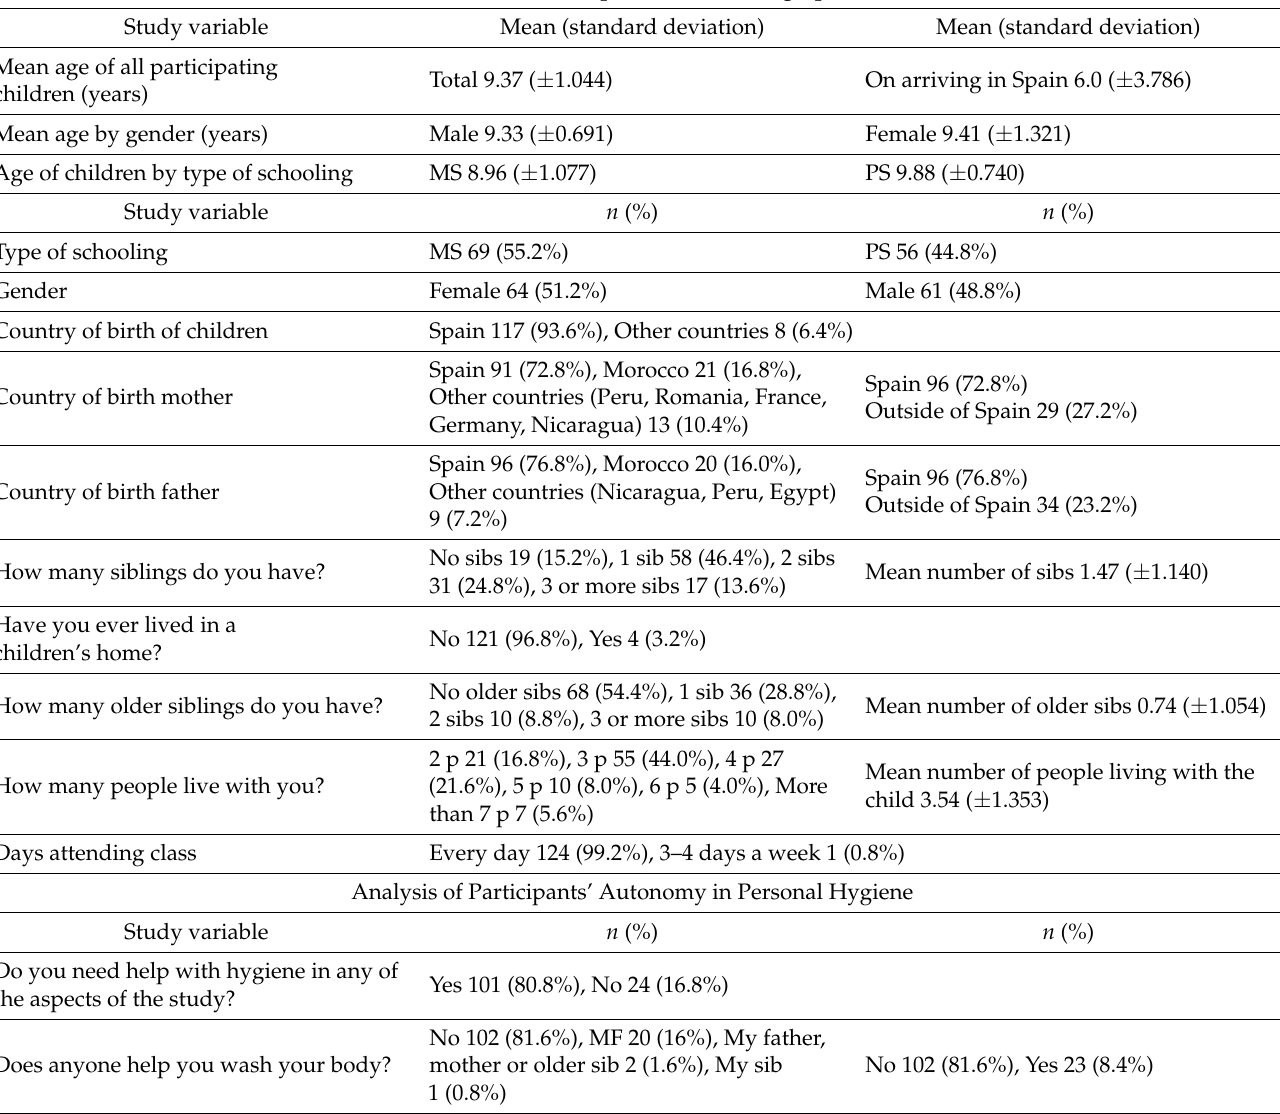
Table A1. Sociodemographic characteristics of participants and their families. Analysis of hygiene autonomy, knowledge, and habits of participants in the aspects of hygiene